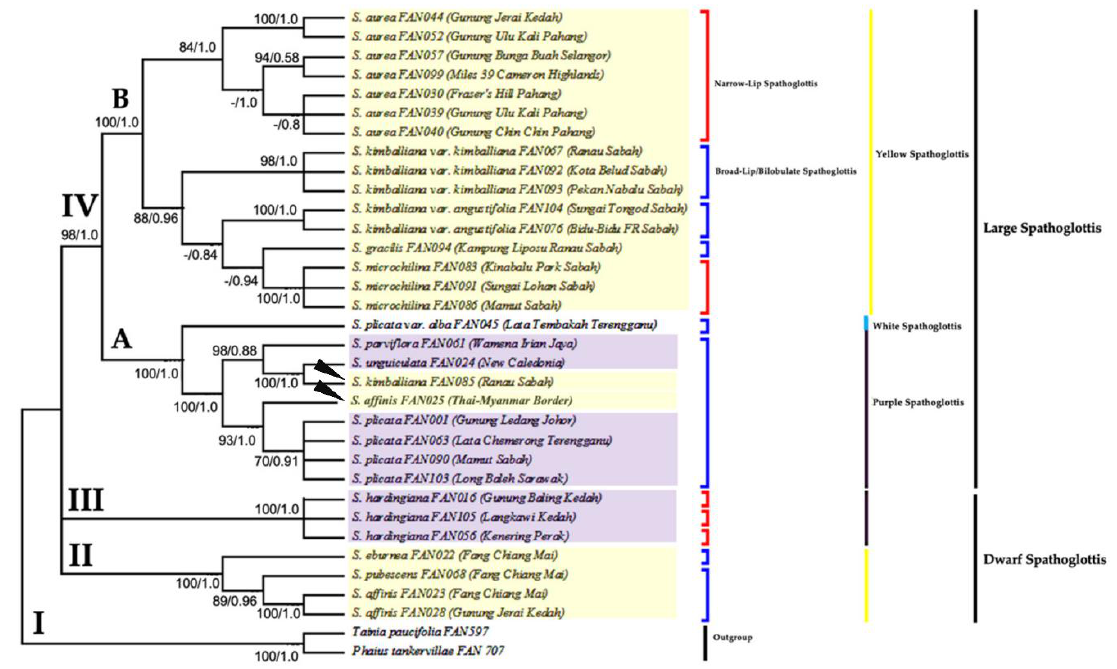
Figure 6. The combined majority-rule consensus tree results from ML analysis and optimal tree results from Bayesian analysis generated from the combined plastid and nuclear gene dataset. Number below branches are bootstrap percentages ≥ 50 and probability values ≥ 0.5 (BS/PP). Clade II–IV holds all ingroups of genus Spathoglottis ; Clade I indicates outgroup. The Dwarf Yellow Spathoglottis (Clade II) formed a basal group; while the Dwarf Purple Spathoglottis (Clade III) is sister to all Large Spathoglottis species. Clade IV that comprises of the Large Spathoglottis groups is monophyletic. Independently, the Large Yellow Spathoglottis group (Subclade IV-B) is monophyletic while the Large Purple Spathoglottis group (Subclade IV-A) is polyphyletic.